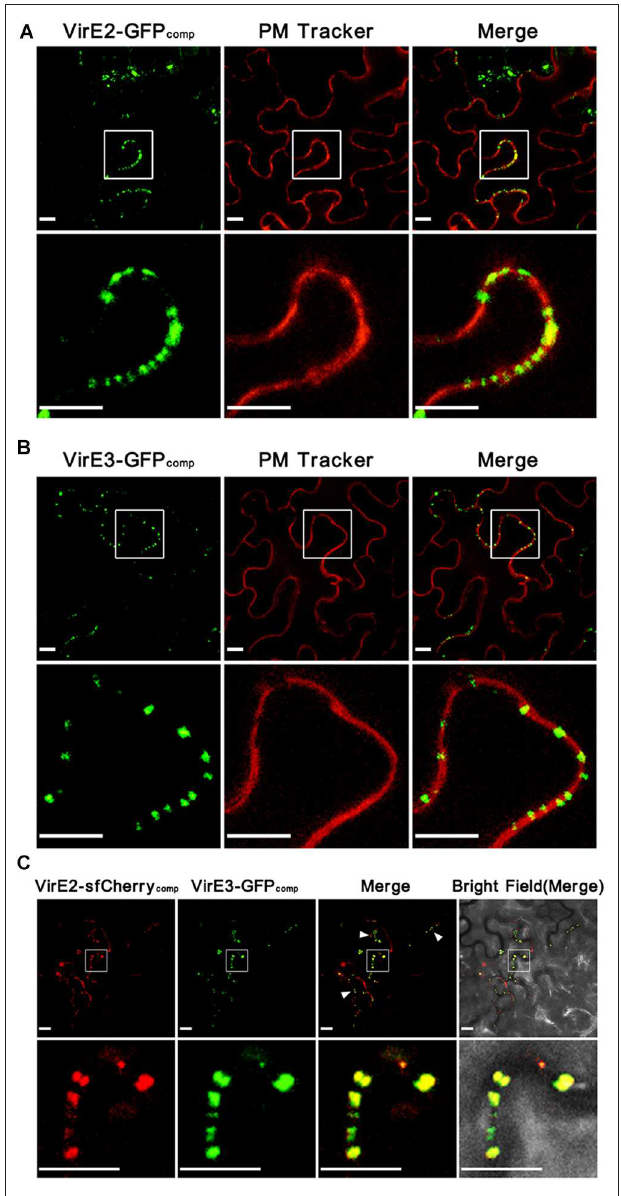
FIGURE 1 | Agrobacterium -delivered VirE2 and VirE3 co-localize with each other at the cytoplasmic side of the host plasma membrane. (A) Accumulation of Agrobacterium -delivered VirE2 on the host plasma membrane. Wild-type N. benthamiana leaves were infiltrated with evenly mixed A. tumefaciens , EHA105 virE2::GFP11 containing a binary plasmid pGFP1–10 (expressing GFP1–10 on T-DNA) and EHA105 virE2::GFP11 containing a binary plasmid pm-rb (expressing a plasma membrane [PM] tracker on T-DNA). A representative image is shown (upper panel). The boxed areas are enlarged to highlight the punctate structures of VirE2 on the host plasma membrane (lower panel). Scale bars, 10 µ m. (B) Accumulation of Agrobacterium -delivered VirE3 on the host plasma membrane. Wild-type N. benthamiana leaves were infiltrated with evenly mixed A. tumefaciens , EHA105 virE3::GFP11 containing a binary plasmid pGFP1–10 and EHA105 virE3::GFP11 containing a binary plasmid pm-rb. A representative image is shown (upper panel). The boxed areas are enlarged to highlight the punctate structures of VirE3 on the host plasma membrane (lower panel). Scale bars, 10 µ m. (C) VirE2 and VirE3